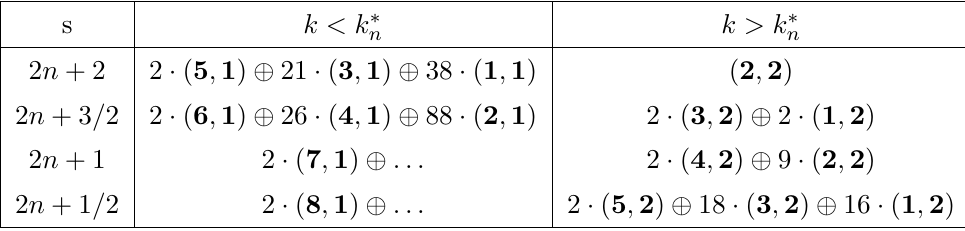
Table 4 . States composing the subleading N = 4 trajectory for di(cid:11)erent values of k